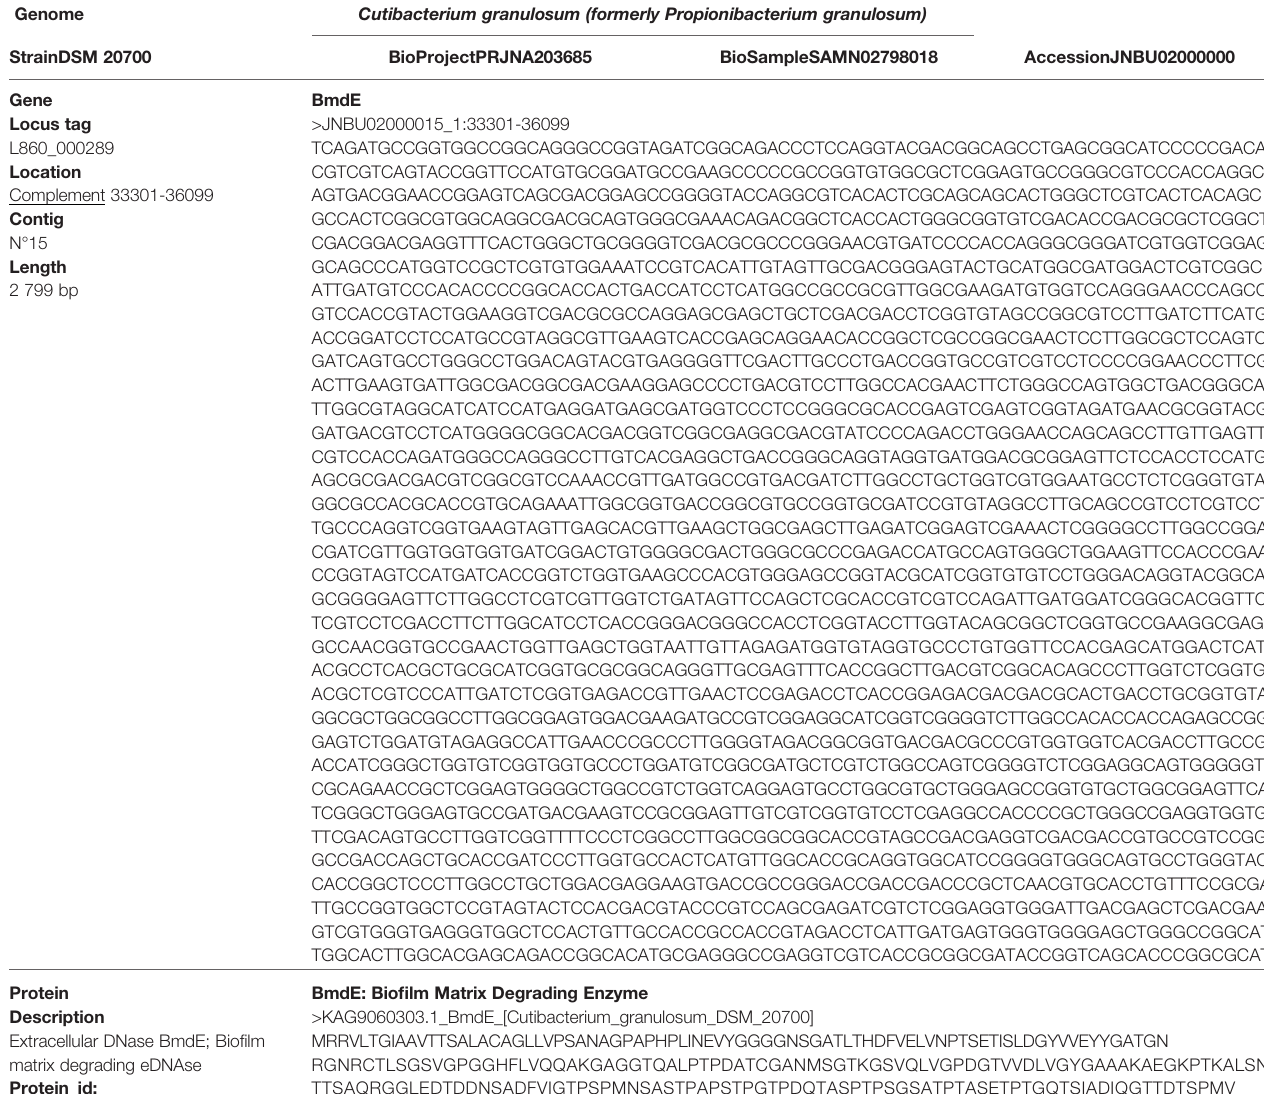
TABLE 1 | P. granulosum genome data and L860_000289 main characteristics.